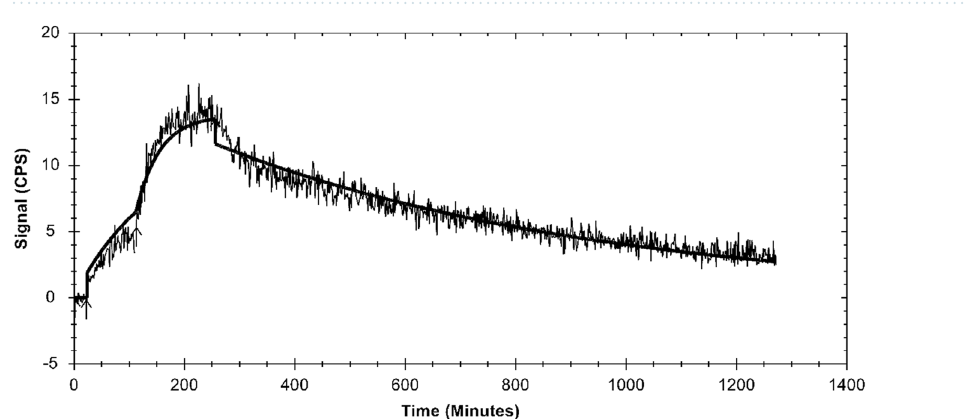
Figure 3. Representative curve from real-time Ligand Tracer measurements of binding kinetics of [ 66 Ga] Ga-NOTA-PEG 2 -RM26. GRPR-expressing PC-3 cells were plated in a dedicated area of 10 cm petri dish an and increasing concentrations of [ 66 Ga]Ga-NOTA-PEG2-RM26 were added stepwise to record association. Solution was replaced with fresh culture media to record dissociation. Data were analyzed with a 1:1 kinetic binding model using TraceDrawer Software (Ridgeview Instruments